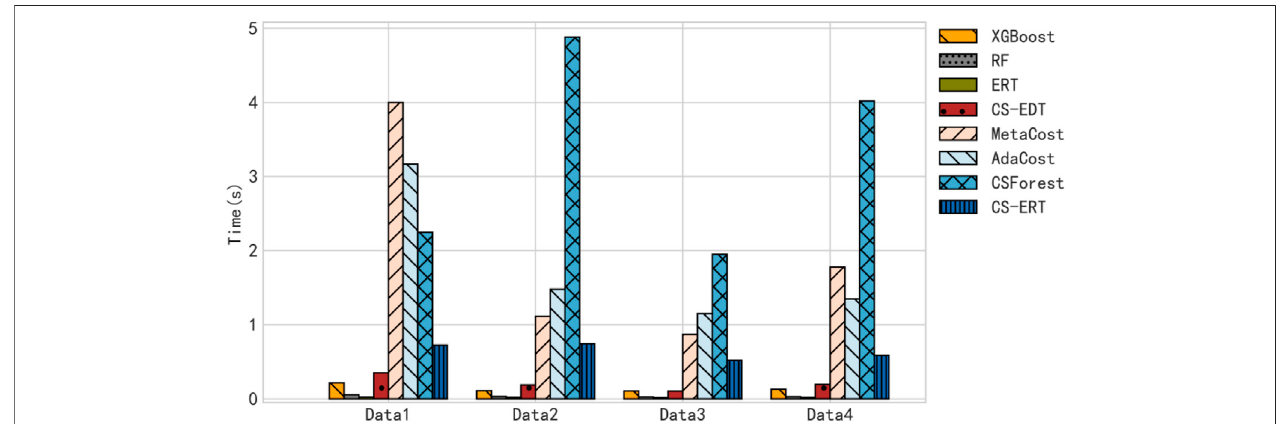
FIGURE 8 | Comparison of the running time for the eight algorithms on the four